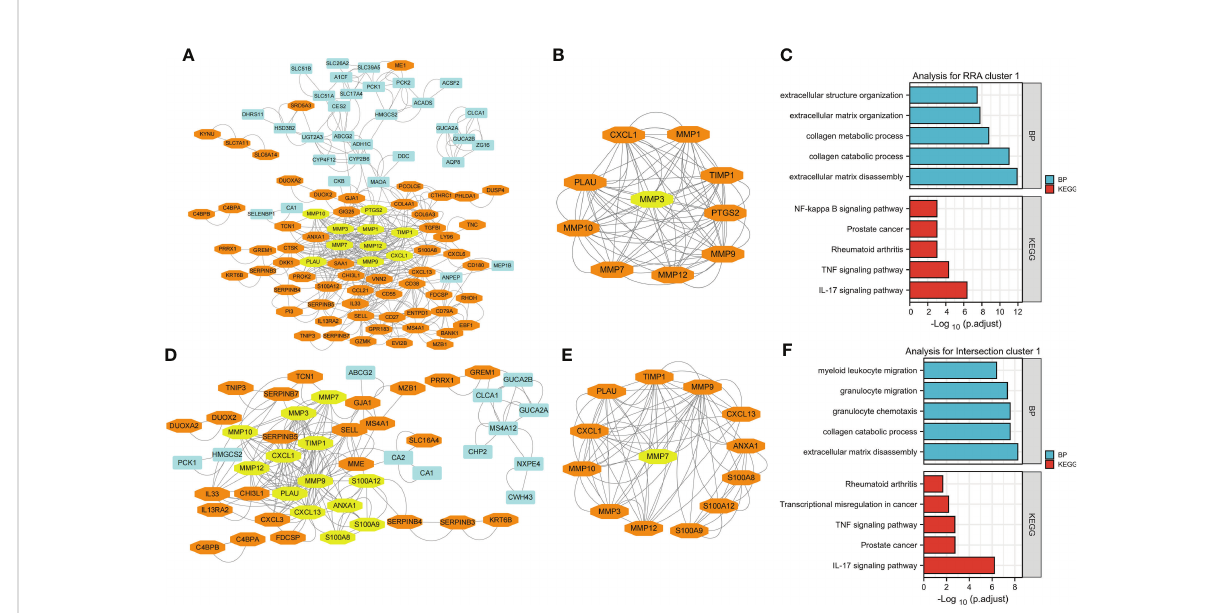
FIGURE 4 Visualization and module identi fi cation using two different PPI networks. (A) RRA-DEGs were mapped using Cytoscape software (genes mainly expressed in CD are indicated in blue, and genes mainly expressed in UC are indicated in orange). Using the MCODE plug-in, the module with the highest scores was identi fi ed (indicated in yellow). (B) The identi fi ed module comprised MMP1, MMP12, PLAU, MMP9, CXCL1, MMP10, PTGS2, TIMP1, and MMP7 (indicated in orange), with MMP3 as the seed gene (indicated in yellow). Functional enrichment analyses of the genes in the MMP-associated module were performed (C) . (D) The intersection-DEGs were mapped using Cytoscape software (genes mainly expressed in CD are indicated in blue, and genes mainly expressed in UC are indicated in orange). Using the MCODE plug-in, the module with the highest scores was identi fi ed (indicated in yellow). (E) The identi fi ed module comprised MMP12, MMP10, MMP3, MMP9, TIMP1, CXCL1, PLAU, S100A9, CXCL13, S100A8, ANXA1 and S100A12 (indicated in orange), with MMP7 as the seed gene (indicated in yellow). Functional enrichment analyses of the genes in the MMP-associated module were performed (F)